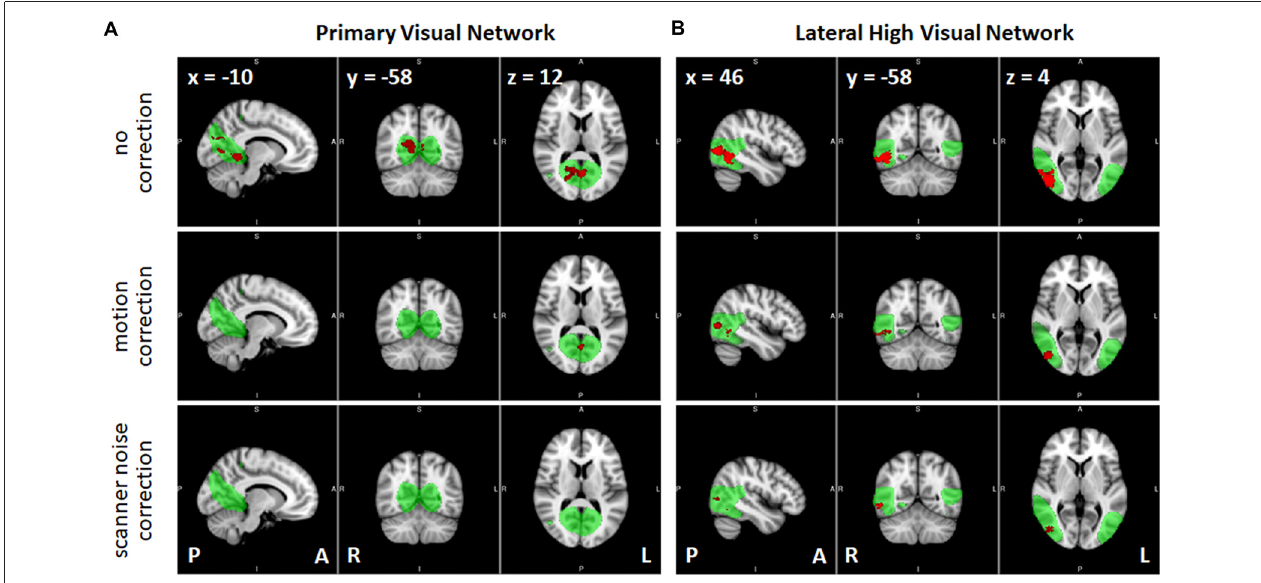
FIGURE 6 | Effects of the correction methods in removing the spurious significant connectivity changes, shown in red, between sessions S1 and S2 observed in (A) primary visual network and (B) high visual network (lateral). RSNs are shown in green (group independent components (ICs) z > 3). P, posterior; A, anterior; L, left; R,